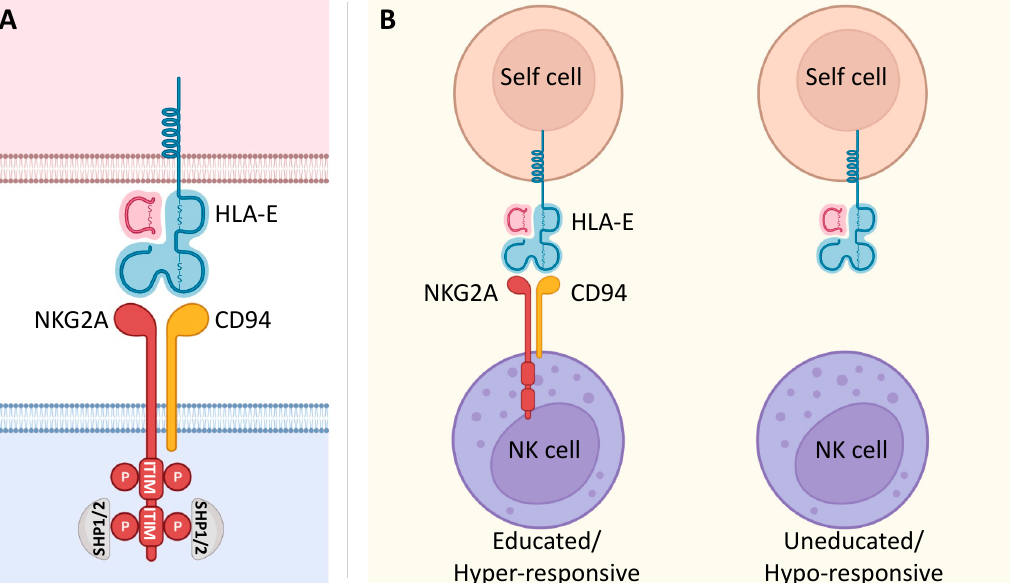
Figure 1. NKG2A signaling and its involvement in NK cell education. ( A ) The C-type lectin NKG2A receptor forms a heterodimer with CD94. It is characterized by a long cytoplasmic domain that contains two ITIMs. Upon binding to its ligand, inhibitory signaling of the non-classical MHC class I molecule HLA-E is based on the phosphorylation of two ITIMs with the consequent recruitment of the intracellular phosphatases SHP-1 and SHP-2. ( B ) NKG2A is known to be involved in NK cell education. In fact, the interaction of NKG2A with its ligand HLA-E renders NK cells educated and hyper-responsive, setting their effector functions at higher levels in response to stimulatory activation. On the other hand, NK cells that fail this interaction due to the lack of NKG2A are uneducated and hypo-responsive.